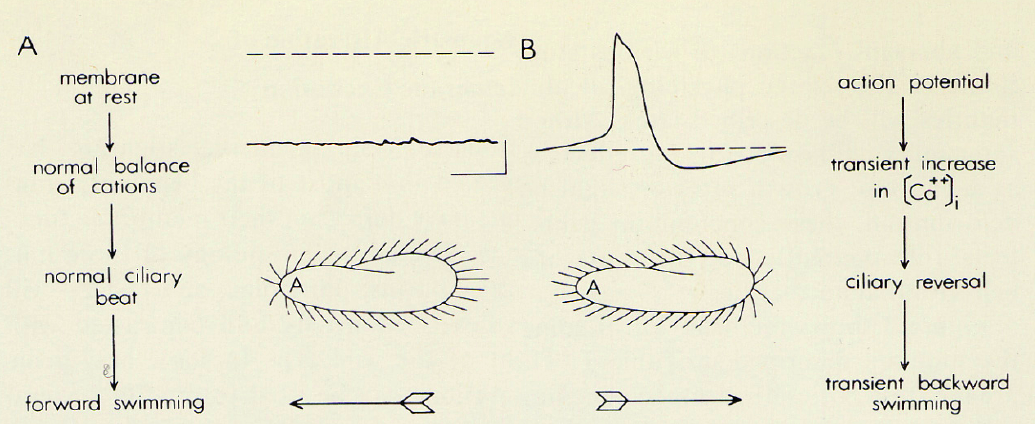
Figure 2. A. These images are to demonstrate that the intracellular membrane potential of Paramecium is negative (about − 25 to − 40 mV); the corresponding ciliary beat is toward the posterior of the cell and the cell swims forward. B. In depolarizing solutions, like high K + or Ba 2+ , the cell’s membrane potential depolarizes and reaches threshold for the action potential. During the action potential calcium enters the cilia through voltage gated channels, the high levels of Ca 2+ change the power stroke of the cilia, which now beat most strongly toward the anterior and move the cell backward. The action potential is quickly over and the calcium is removed from or sequestered in the cilia, allowing the ciliary beat and swimming to return to normal. With permission from Science